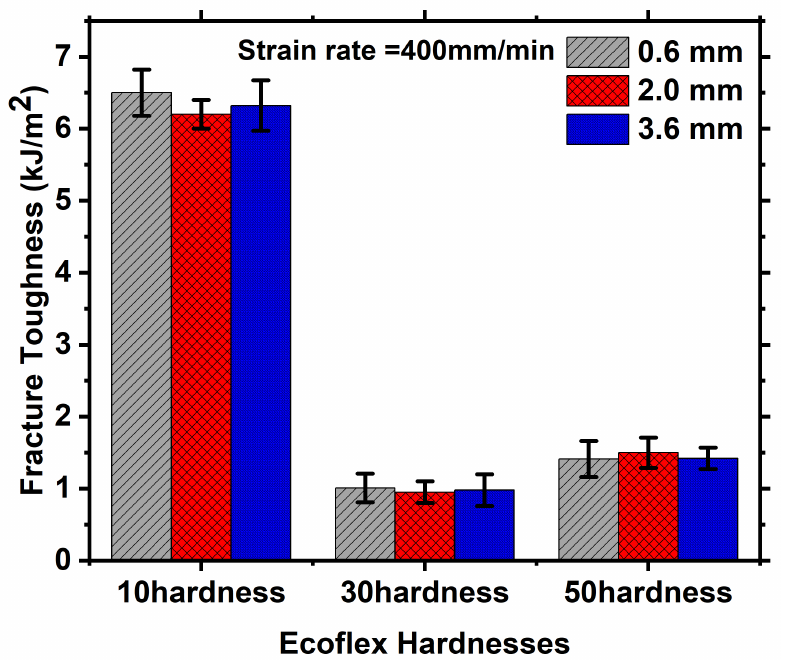
Figure 8. Bar diagram to represent the fracture toughness for different hardness of 0.6 mm, 2 mm and 3.6 mm,